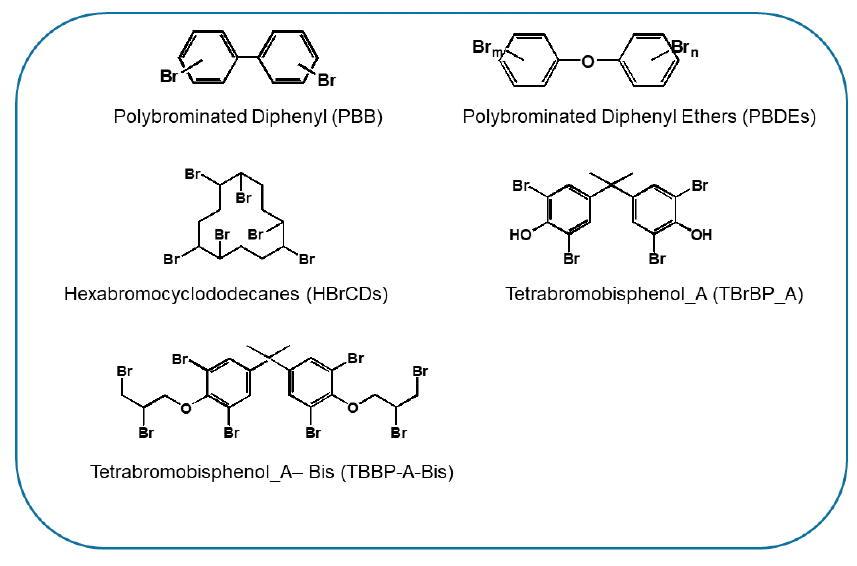
Figure 4. Chemical structure of some classes of halogenated flame